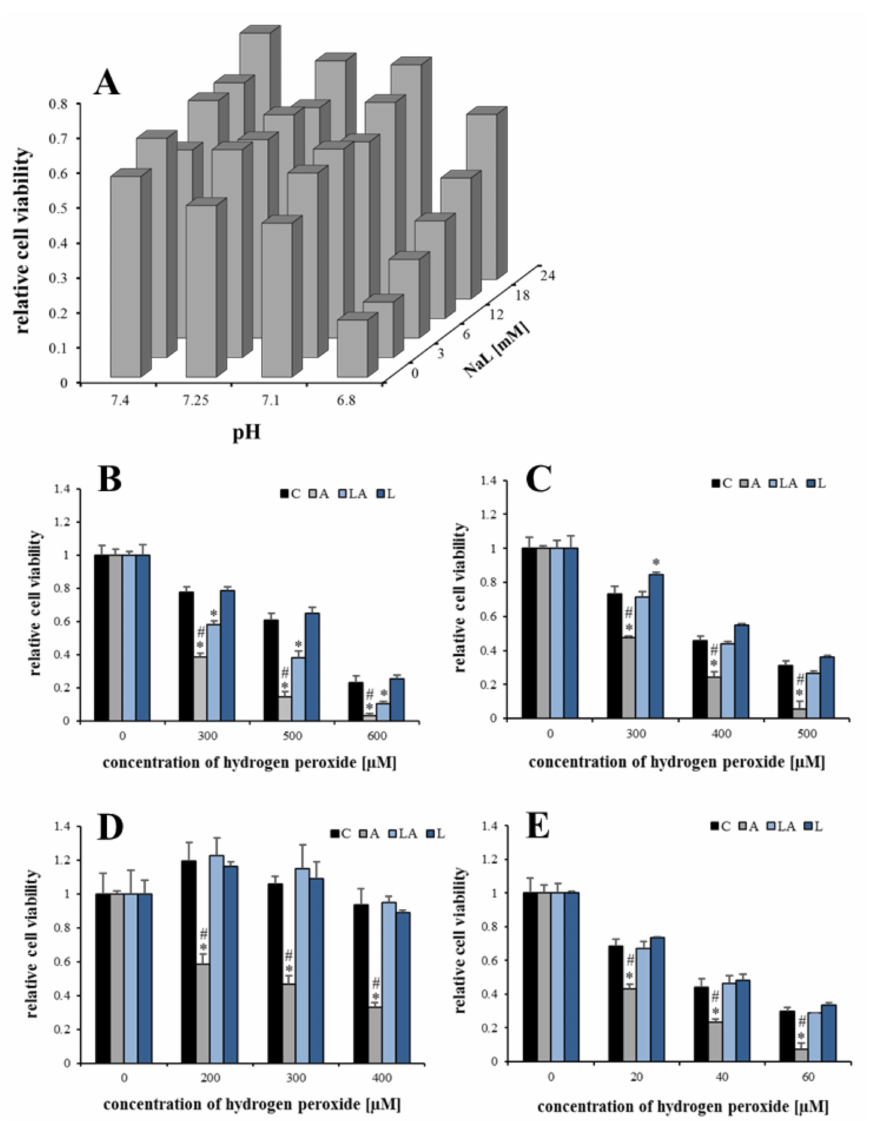
Figure 1. The effect of lactic acidosis on cell sensitivity to oxidative insult. ( A ) Viability of PaTu-8902 cells cultured in media of different pH and concentrations of lactate anion (NaL) for 72 h and then treated with 500 µ M hydrogen peroxide. Viability of ( B ) PaTu-8902, ( C ) HeLa, ( D ) Hep G2, and ( E ) noncancerous HDF cells cultured in experimental media for 72 h and then treated with indicated concentrations of hydrogen peroxide. Viability was measured by resazurin assay. C, control; A, acidosis; LA, lactic acidosis; L, high lactate (* p < 0.05 compared to C, # p < 0.05 when comparing A and